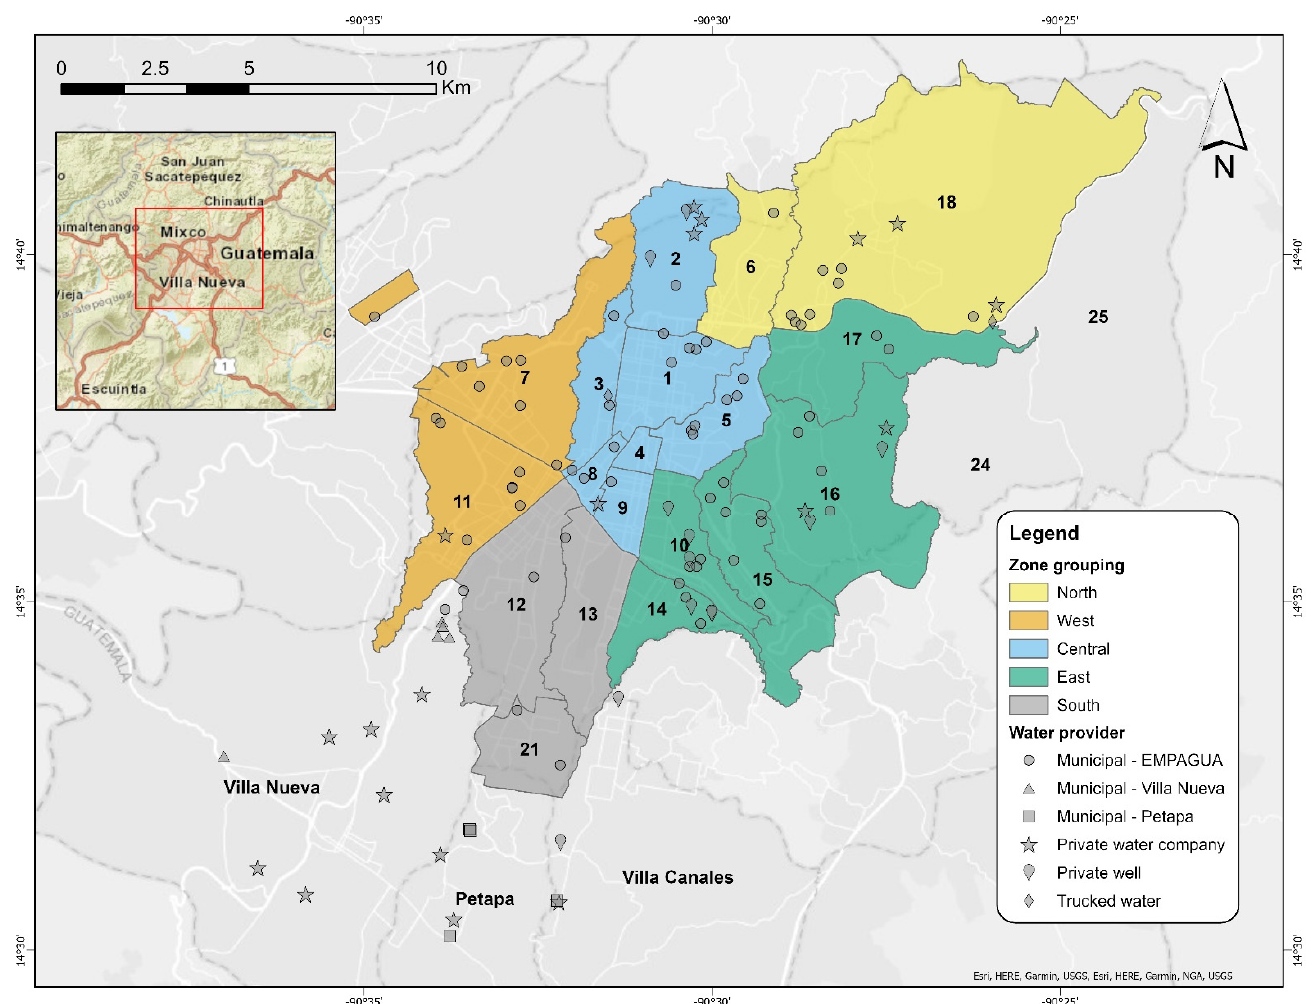
Figure 2. Map of the Guatemala City metropolitan area and the approximate locations and water providers of the study participants. Colors show the different zone groupings. Symbols indicate the water provider.